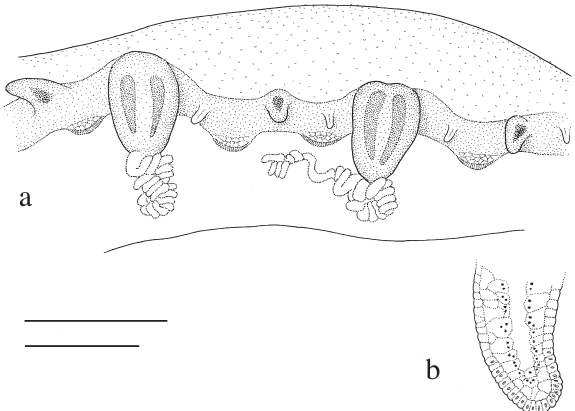
F IG . 6. – Parateclaia euromarge , detail of the umbrella margin: (a) abaxial view showing the elongated conical marginal bulbs, each with two large brown bands, the cordyliform conical structures, and the open statocysts between successive marginal tentacles. Scale: 0.5 mm ; (b) microscopic view of the cordyliform structures with terminal cnidocysts. Scale: 0.05